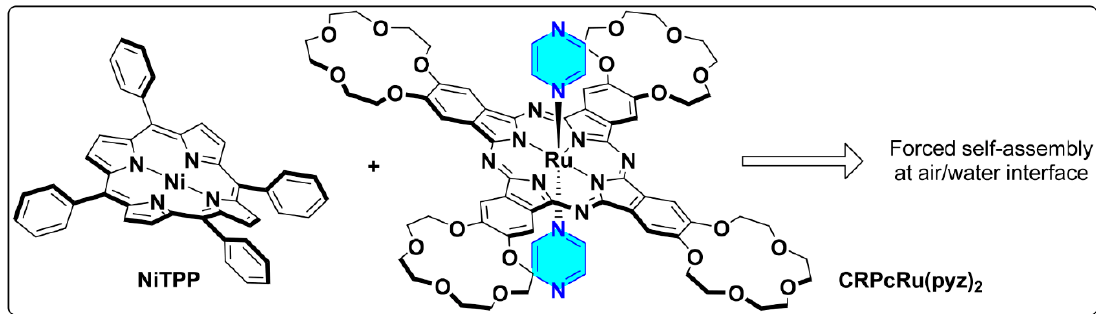
Figure 3. Components of a supramolecular garland, formed by forced coordination of pyrazine ligands to Ni(II) centers in the present work.